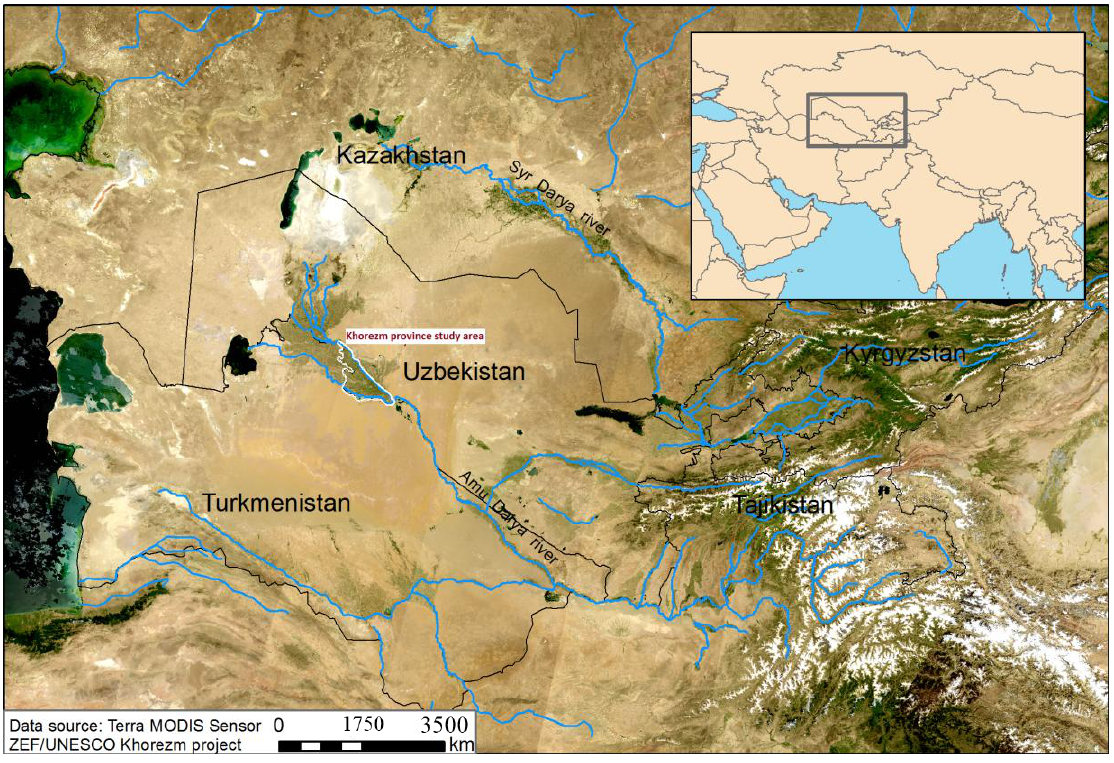
Figure 1. Map of Uzbekistan and the irrigated areas in the southern parts along the Amudarya river [2] (note: Khorezm province is delineated with a white